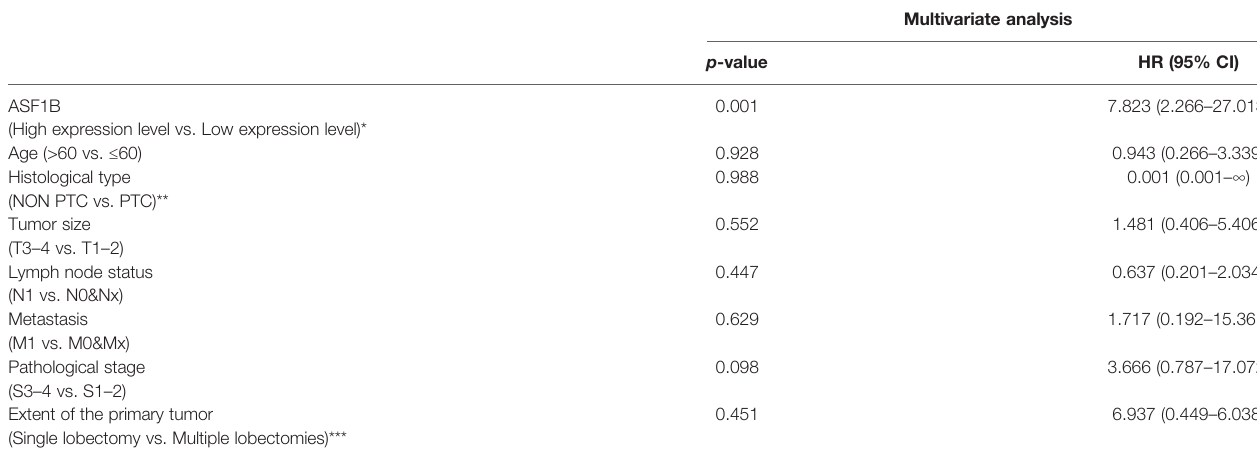
TABLE 1 | Multivariate Cox regression analysis in male TC patients.